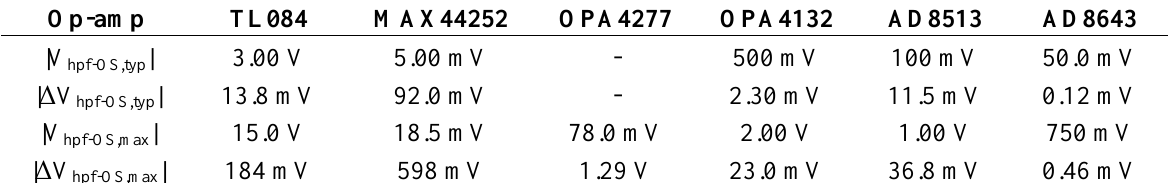
Table 6. Output DC offset estimated from the manufacturer specifications. Values obtained at the output v for the HPF in Figure 4. o